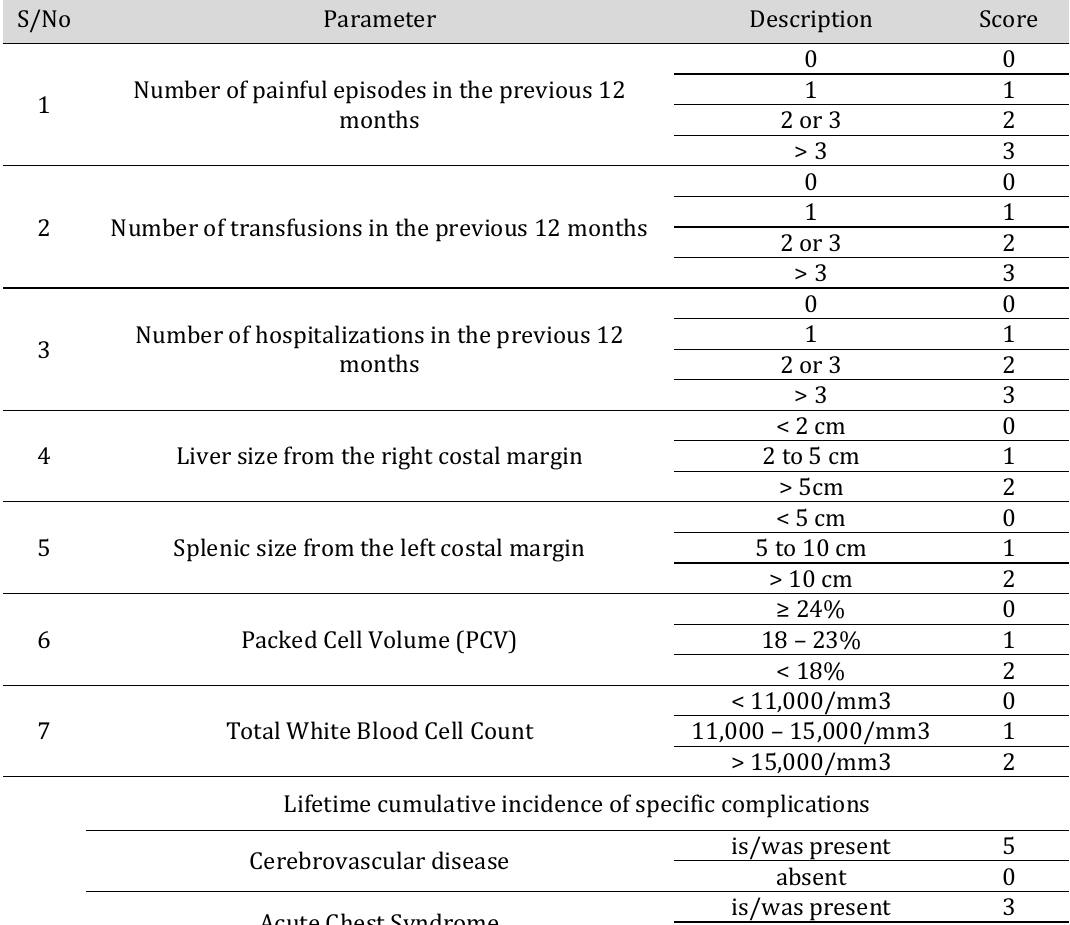
Table 1. Clinical severity scoring system for Sickle Cell Anaemia as proposed by [16].